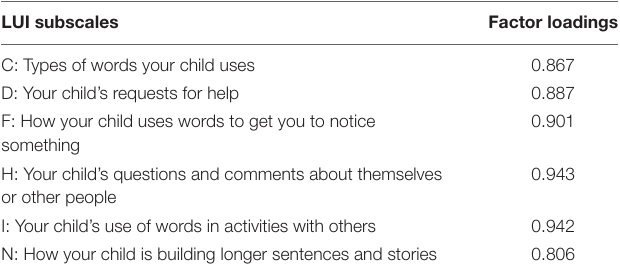
TABLE 3 | LUI-6 subscales principal component analysis, rotated factor loadings based on parental reported use of English (sole or in addition to home language) ( N =